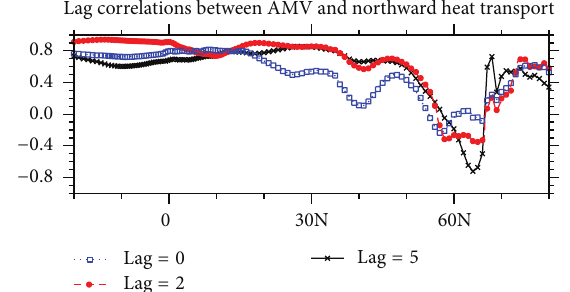
Figure 8: Lag correlations between the AMV index and anomalous northward oceanic heat transport (units: PW) from 20 ∘ S to 80 ∘ N for the ensemble mean of the INIT runs. The AMV index is averaged over the hindcast years 6–9 (red line in Figure 5(c)). Lag 0 represents simultaneouscorrelation.Lags2and5representthattheAMVindex lags the heat transport anomalies by 2 and 5 years, respectively. That is, the heat transport anomalies are averaged over the hindcast years 6–9 (lag 0), 4–7 (lag 2), and 1–4 (lag 5),